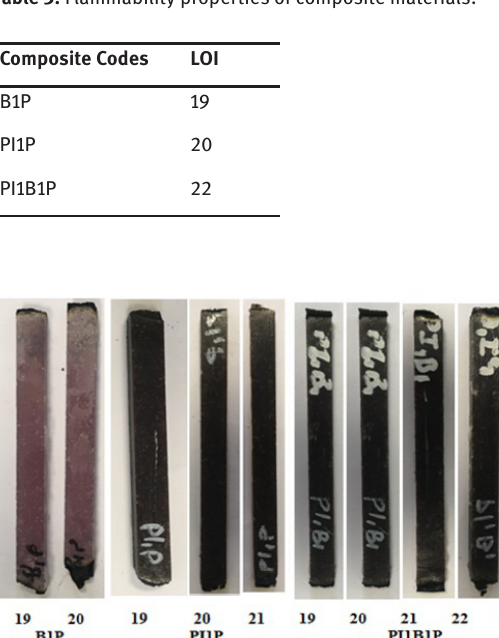
Table 3: Flammability properties of composite